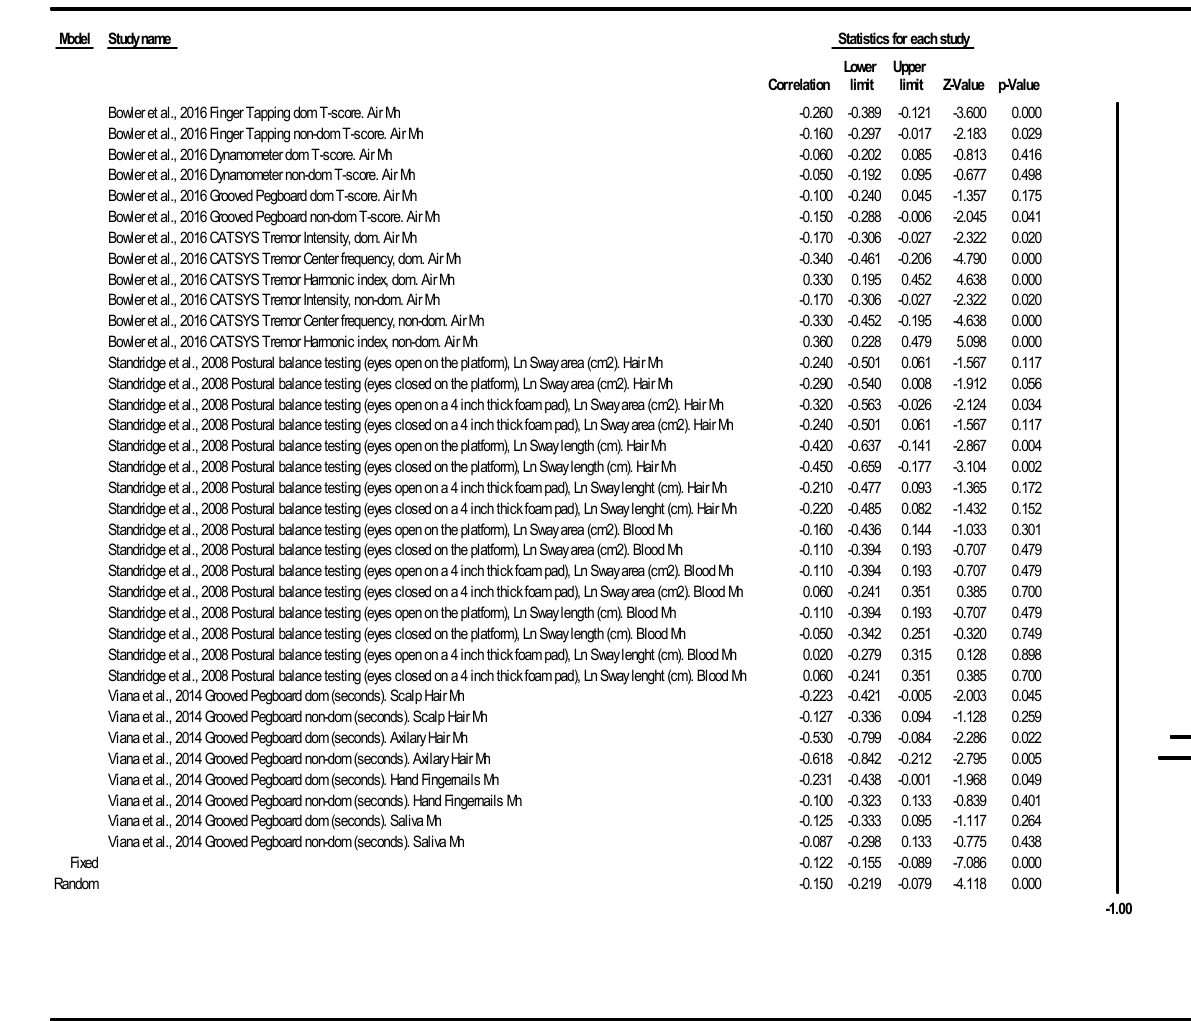
Figure 4. Correlation between cognitive function and exposure to Mn. All tests and all exposures to Mn. Note: a negative correlation indicates that the higher the Mn levels, the worse the motor function.